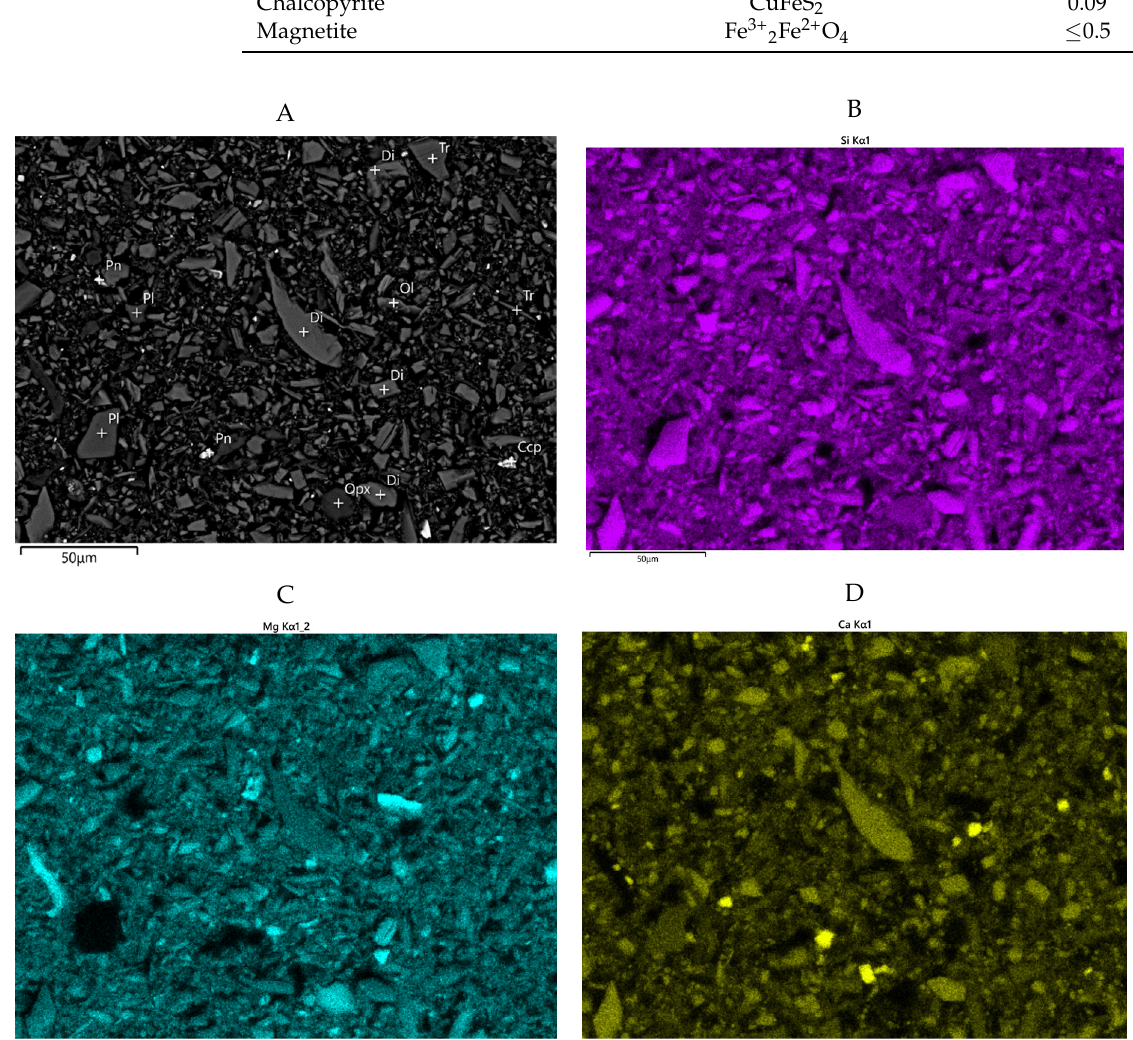
Figure 6. Minerals found in the DAF overflow solids and distribution of elements. ( A ) Backscatter electron image; EDS maps of ( B ) Si, ( C ) Mg and ( D ) Ca